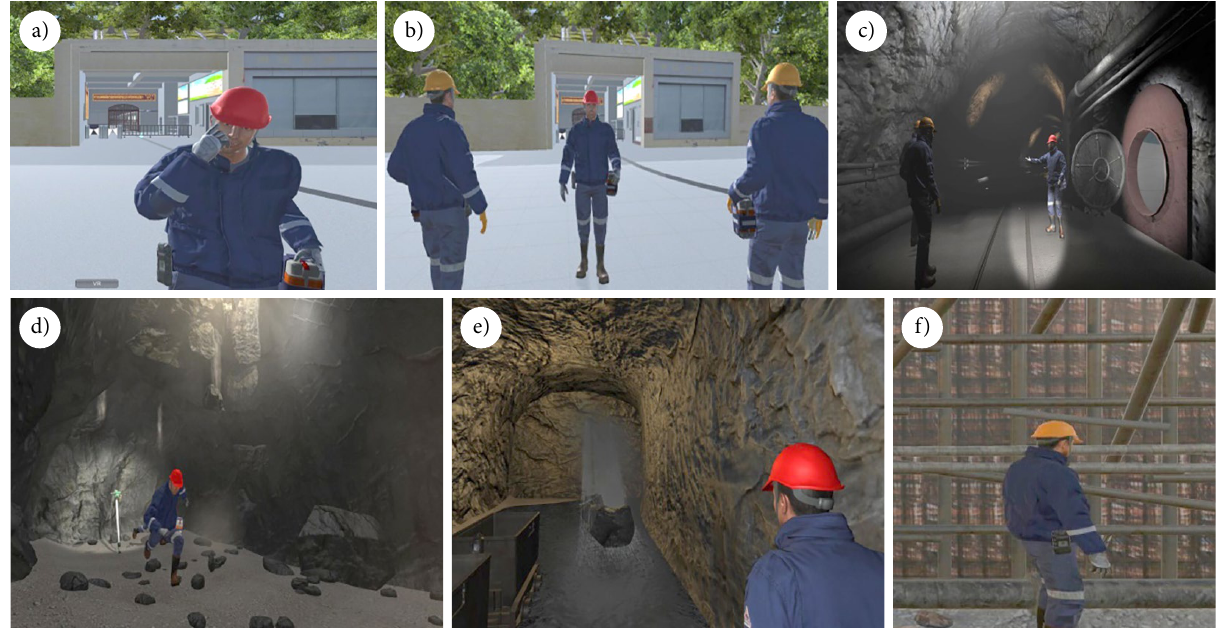
Figure 8. Interface screenshots of the virtual reality safety education before entering